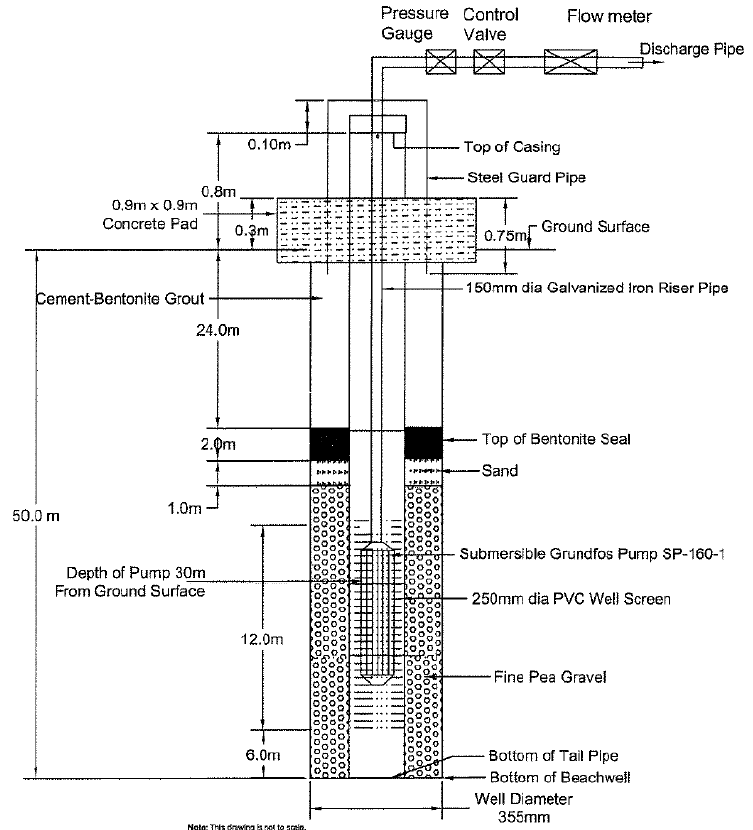
Figure 2. Beach well construction details.